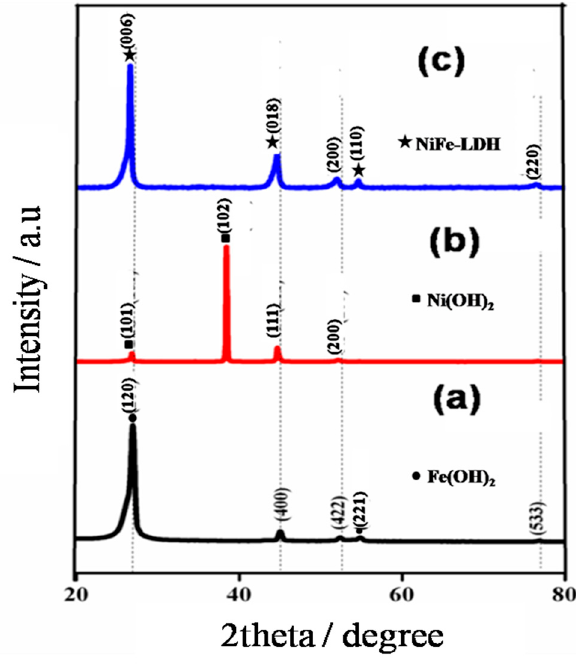
Figure 1. XRD pattern of ( a ) Fe, ( b ) Ni, and ( c ) NiFe-LDH film deposited on the TC sheet. Figure 2 represents the Raman spectra of Fe, Ni, and NiFe-LDH on TC. The peaks